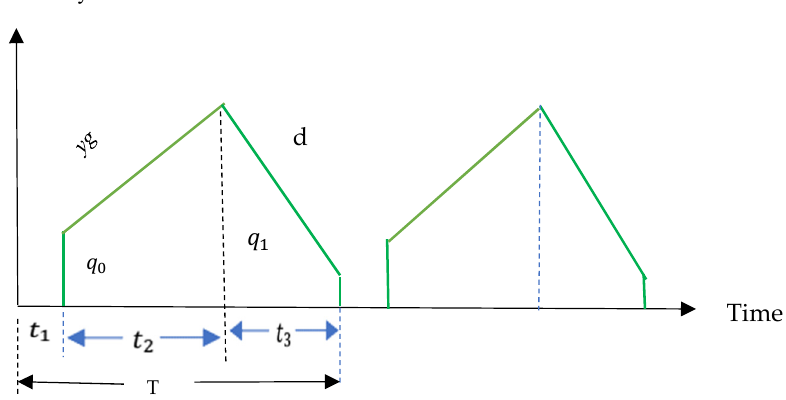
Figure 8. Diagram of the proposed